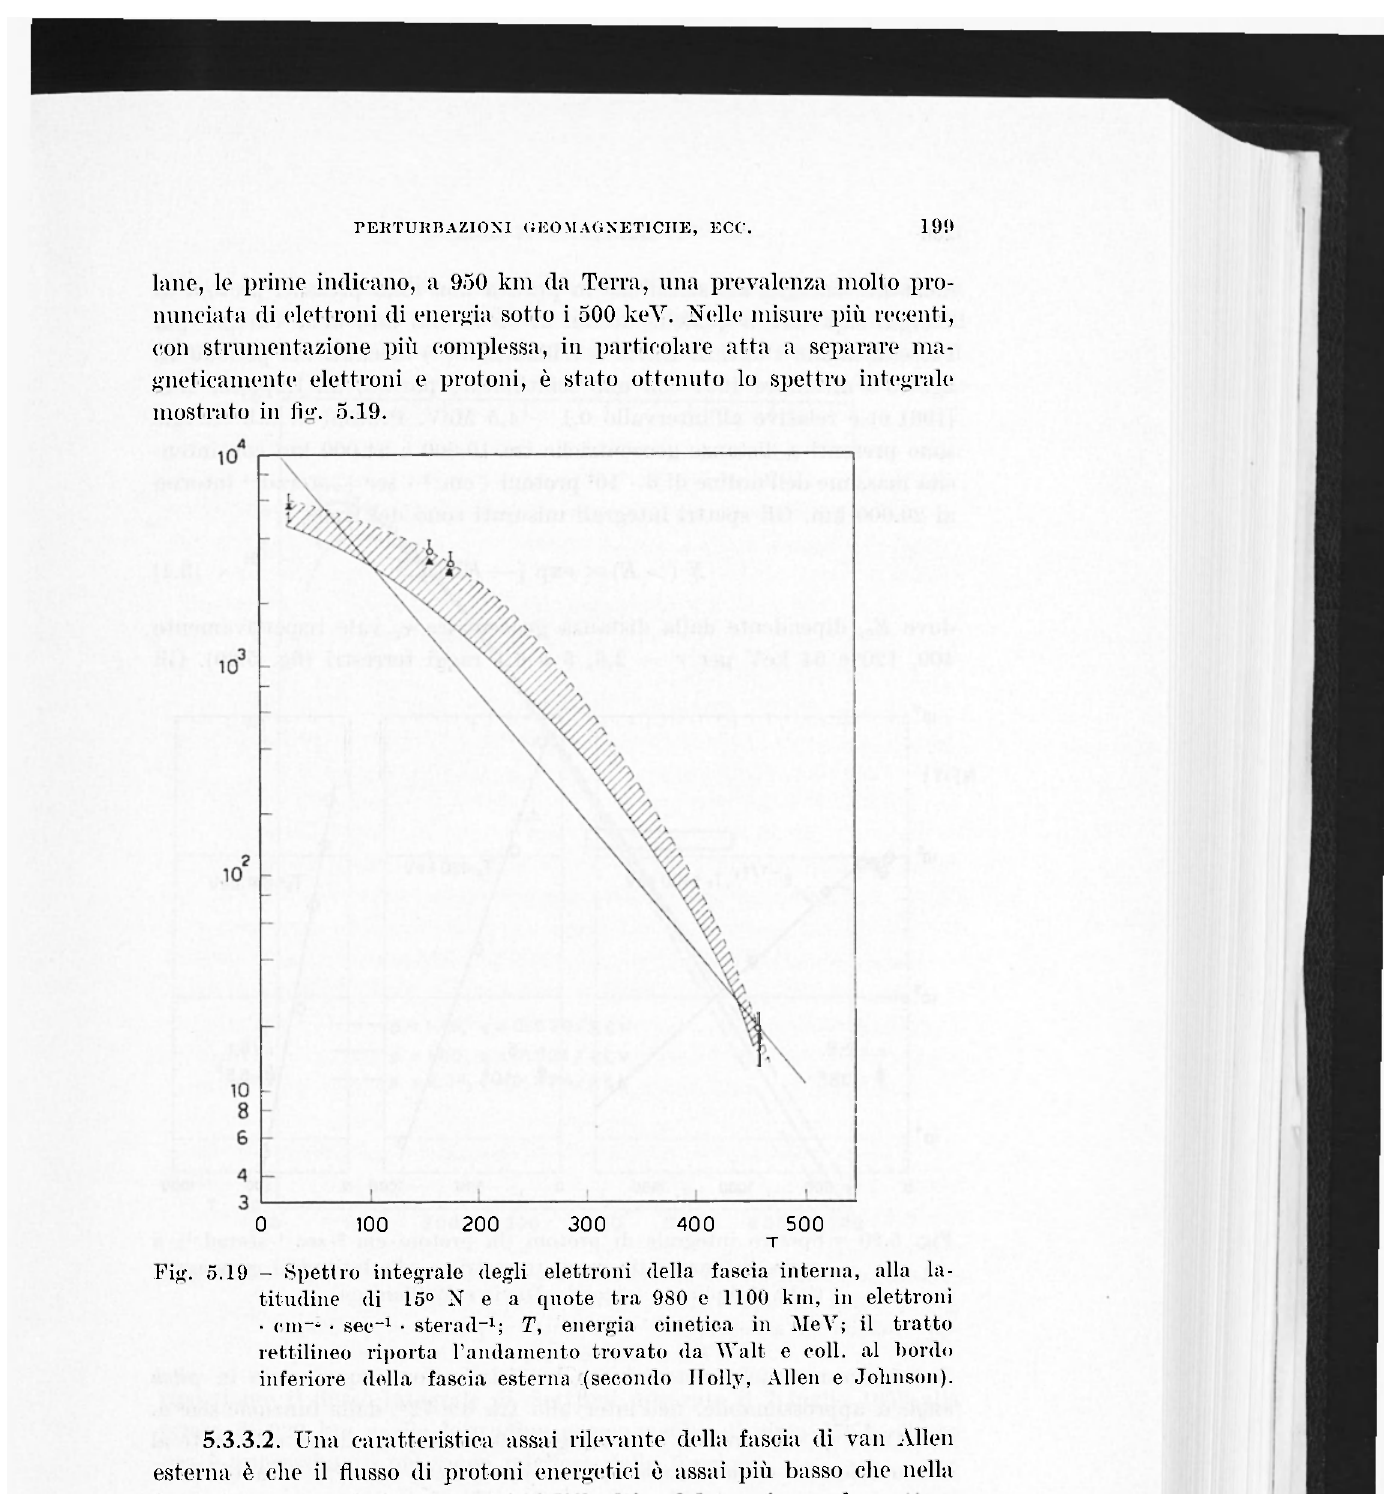
Fig. 5.19 - Spettro integrale degli elettroni della fascia interna, alla la- titudine rettilineo riporta l'andamento trovato da Walt e coli, al bordo inferiore della fascia esterna (secondo Holly, Alien e